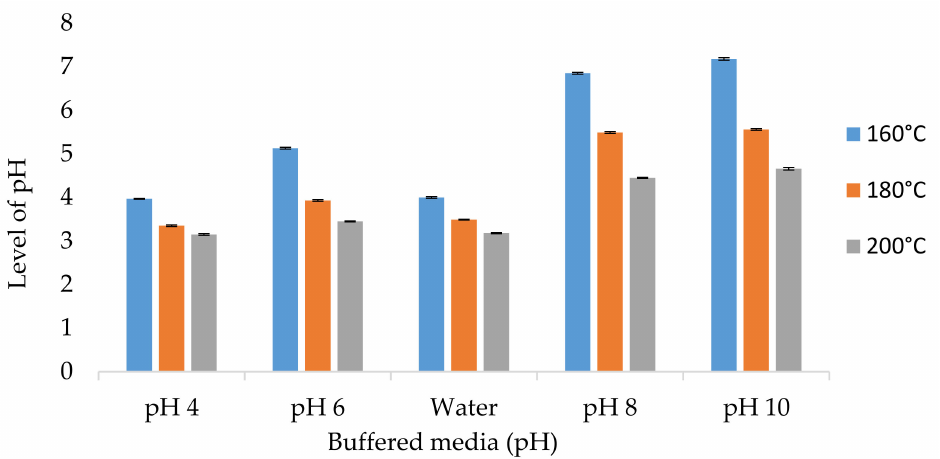
Figure 2. The acidity variation of samples in buffered media and tap water after the hydrothermal